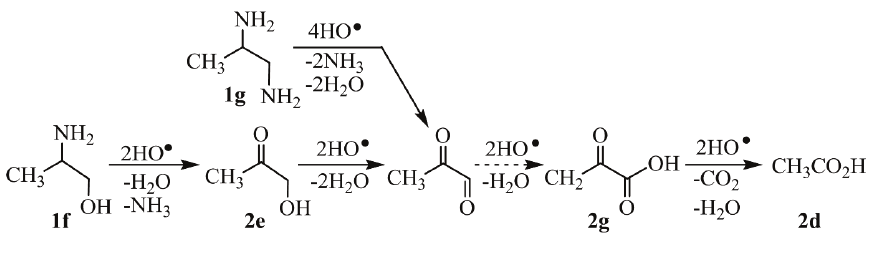
Figure 6. Degradation of 1f – g (Group B) by HO • radical.